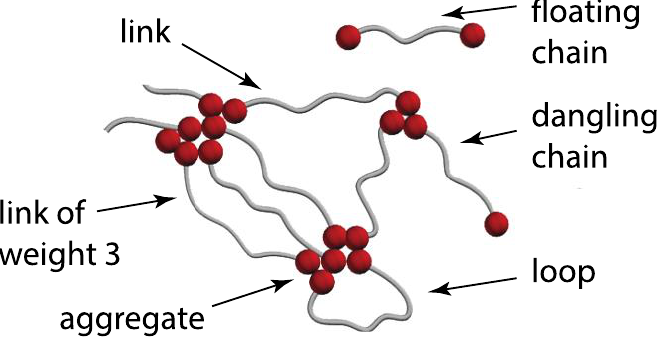
Figure 1. Illustration of possible network topologies. Bead-spring polymers contain 8 beads; those at the ends (red) attract each other. The beads on the gray chains are suppressed for clarity.